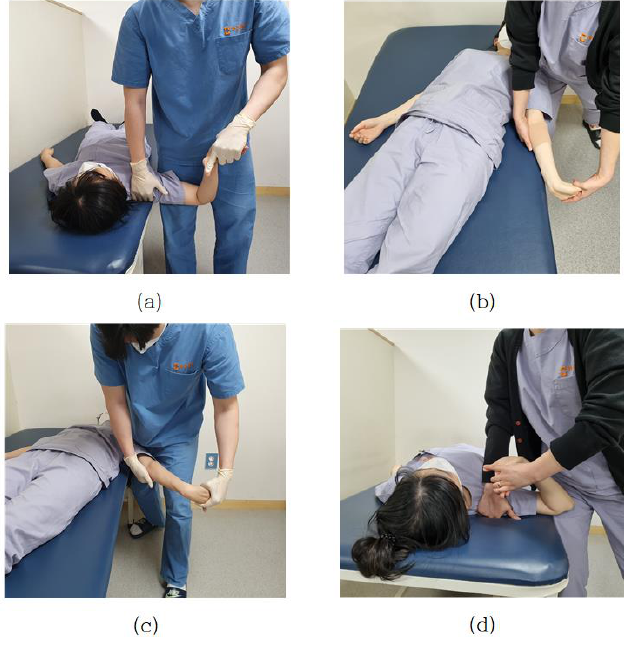
Figure 1. ( a ) Upper Limb Tension Test 1 (ULTT1); ( b ) Upper Limb Tension Test 2A (ULTT2A); ( c )